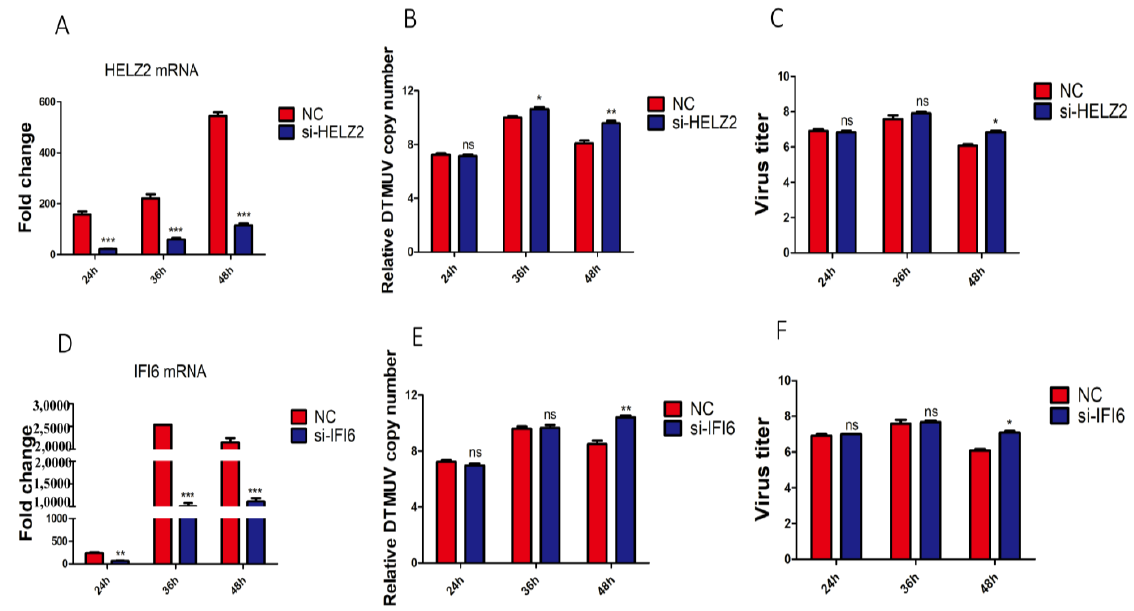
Figure 7. Effects of knockdown of HELZ2 and IFI6 on DTMUV replication in KO-IFNAR1 cells. ( A ) Relative mRNA levels of HELZ2 in HELZ2-knockdown KO-IFNAR1 cells infected with DTMUV. Cells were transfected with siHELZ2 and siNC for 5 h, respectively, and infected with DTMUV at an MOI ⁓ 1, harvested at indicated time points for RT-qPCR with specific primers to determine rel- ative mRNA levels. ( B ) Relative viral RNA levels(Normalized DTMUV copy numb er (log10)per μg of total RNA) harvested from HELZ2-knockdown (siHELZ2) or negative control (siNC) cells at in- dicated times after DTMUV infection. ( C ) Viral titers were determined by TCID50 from the extra- cellular fluids of cells harvested as in ( B ). Error bar represents the standard error of three replicate experiments. ( D ) Relative mRNA levels of IFI6 in IFI6-knockdown KO-IFNAR1 cells infected with DTMUV. Cells were transfected with siIFI6 and siNC for 5 h, respectively, and infected with DTMUV at an MOI ⁓ 1, harvested at indicated time points for RT-qPCR with specific primers to determine relative mRNA levels. ( E ) Relative viral RNA levels(Normalized DTMUV copy number (log10)per μg of total RNA) harvested from IFI6-knockdown (siIFI6) or negative control (siNC) cells at indicated times after DTMUV infection. ( F ) Viral titers were determined by TCID50 from the ex- tracellular fluids of cells harvested as in ( E ). Error bar represents the standard error of three replicate experiments. * p < 0.05; ** p < 0.01, *** p < 0.001; ns, non-significant.